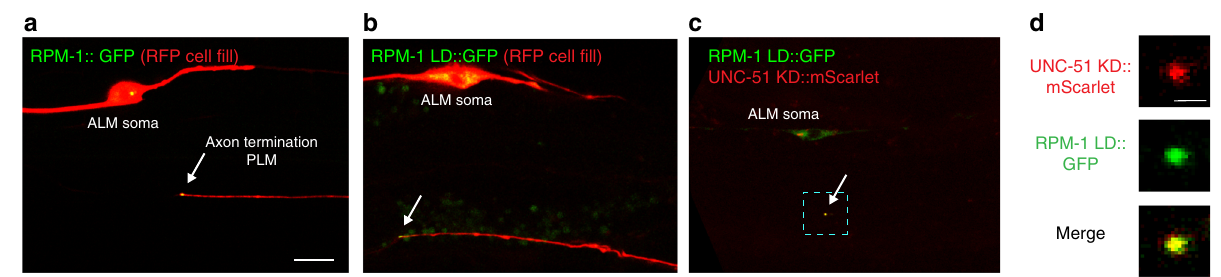
Fig. 6 RPM-1 colocalizes with UNC-51 at axon termination sites. Shown are representative confocal images of axons from PLM neurons of adult wt animals. a RPM-1::GFP and ( b ) RPM-1 LD::GFP (which lacks ubiquitin ligase activity) accumulate in puncta at axon tips (arrows). Scale bar 10 μ m ( c ) UNC-51 KD:: mScarlet colocalizes with RPM-1 LD::GFP at axon tips (arrow). d Zoom-in on region highlighted in c (dashed box) showing UNC-51 KD::mScarlet and RPM-1 LD::GFP colocalize at axon tips. Scale bar 2.5